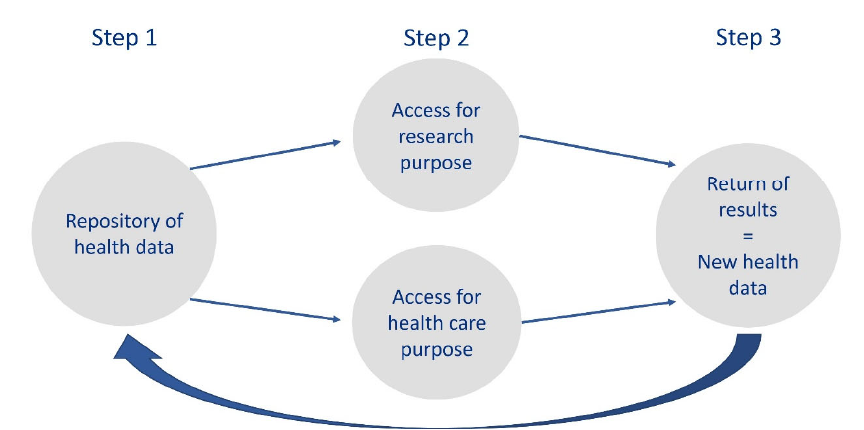
Figure 1. Circular dataflow in a personal health record.